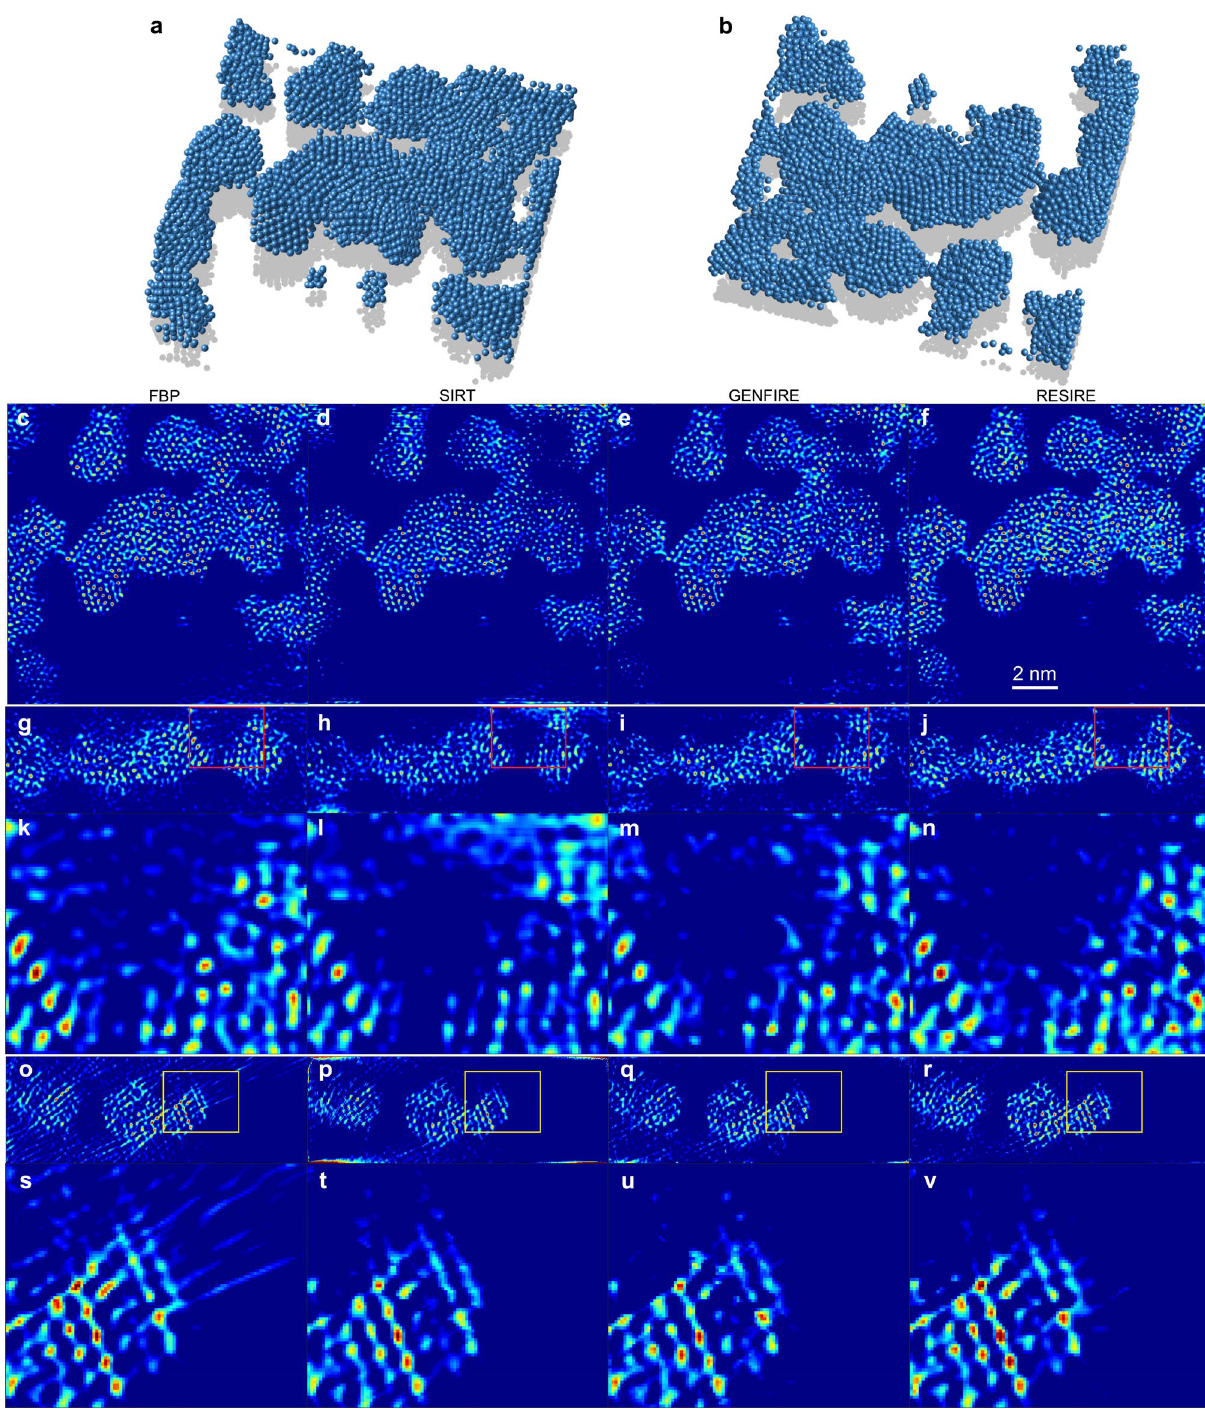
Figure 4. 3D reconstruction of an amorphous Ta film at atomic resolution. ( a – b ), 3D atomic model of the amorphous Ta thin film at two different orientations, reconstructed by RESIRE. ( c – f ), 1.61-Å-thick central slices of the amorphous thin film in the XY plane, reconstructed by FBP, SIRT, GENFIRE and RESIRE, respectively. ( g – j ), 1.61-Å-thick central slices in the YZ plane of the reconstructions, where the missing wedge direction is along the z-axis. ( k – n ), magnified regions in ( g – j ) (red squares), showing that RESIRE produces a high quality reconstruction with least artifacts. ( o – r ), 1.61-Å-thick central slices in the XZ plane of the reconstructions. ( s – v ), magnified regions in ( o – r ) (yellow squares). Compared with the other methods, RESIRE shows less peripheral noise, more easily detectable atomic features and reduces missing wedge